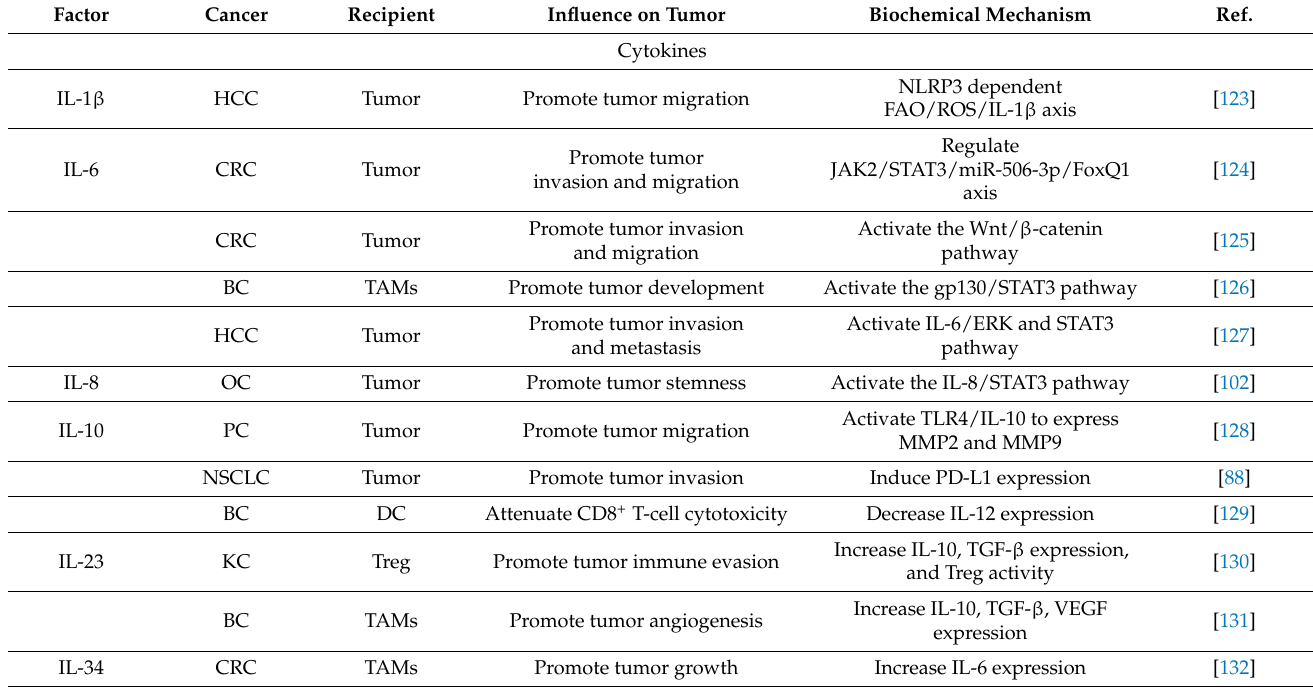
Table 3. TAM-associated factors and their targeted roles in